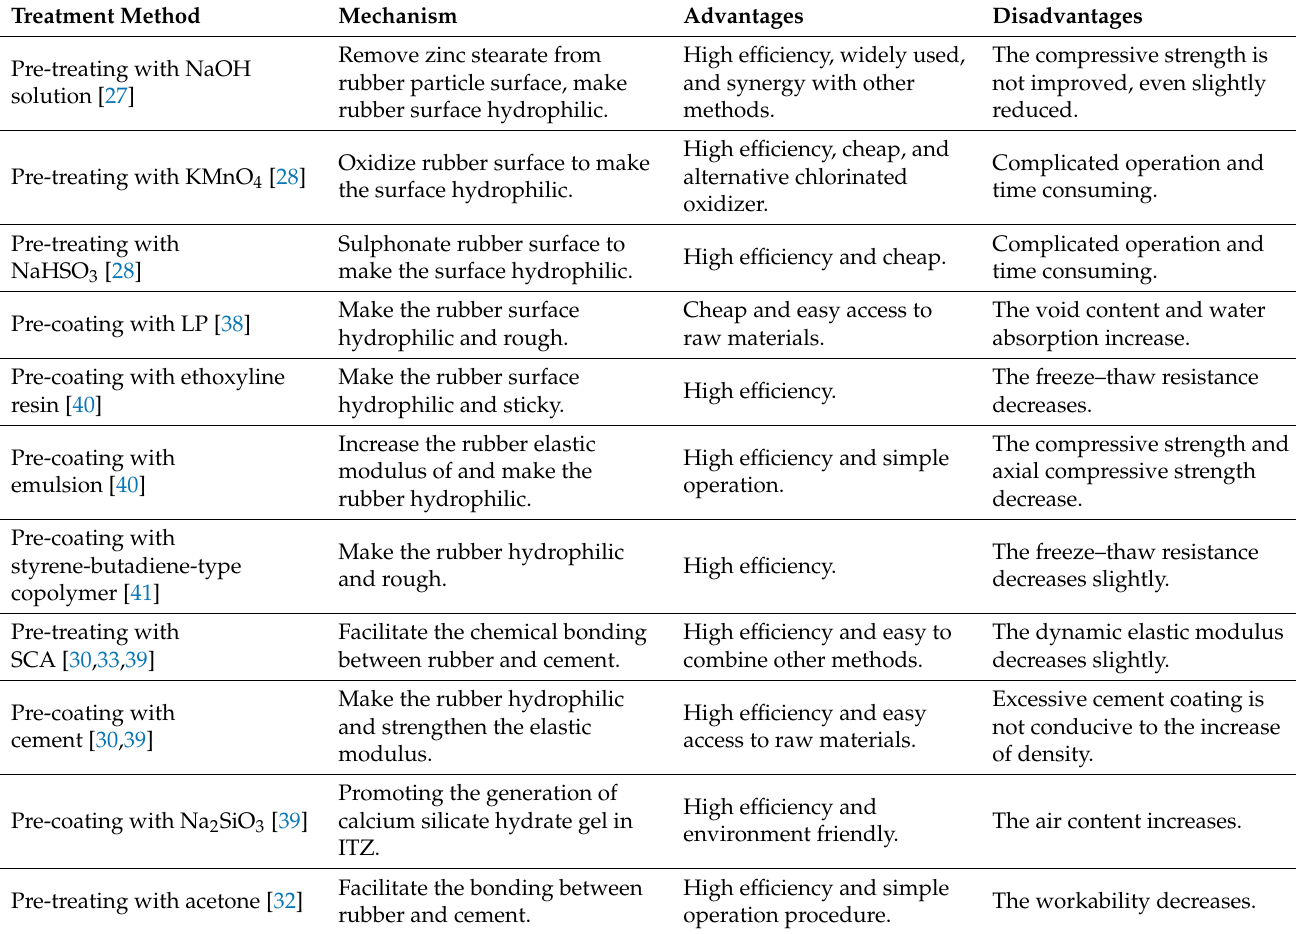
Table 1. Comparison of various treatment methods of rubber waste on